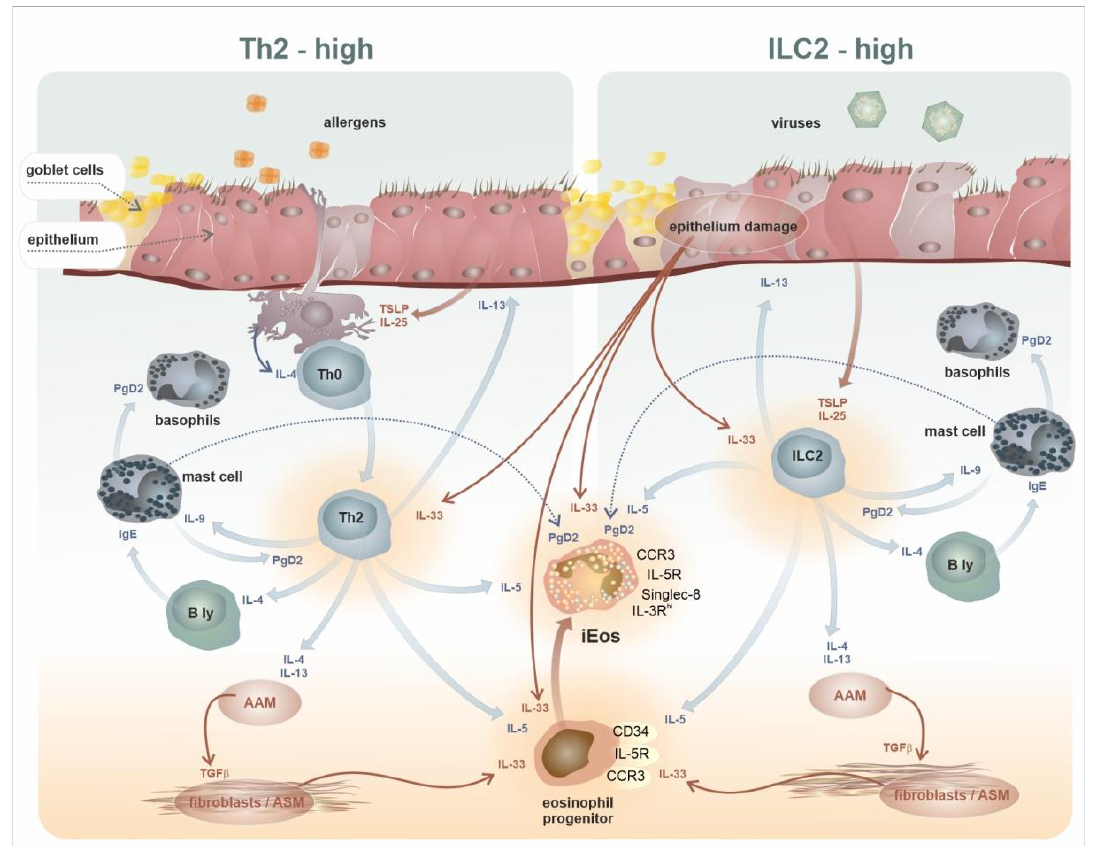
Figure 6. Central role of eosinophils in the complex Type 2-high immune reaction. The complex immunopathology in type 2-high inflammation involves many distinct cell types from the immune system and the tissue interstitium and epithelium. All of these cells can react to and produce signalling molecules, such as cytokines or prostaglandins. The eosinophils (either as progenitors or as mature—proinflammatory cells) are at the core of these processes. The eosinophils particularly respond to IL-5 but also to PgD2, eotaxins, or IL-33. The primary sources of IL-5 are Th2 or ILC2 cells. Th2 cells orchestrate antigen-specific allergic reactivity (specific immune reaction). On the contrary, ILC2 cells are activated independently on specific antigens (innate immune response). Both signalling pathways (Th2-high and ILC2-high) represent, in general, an axis symmetry.